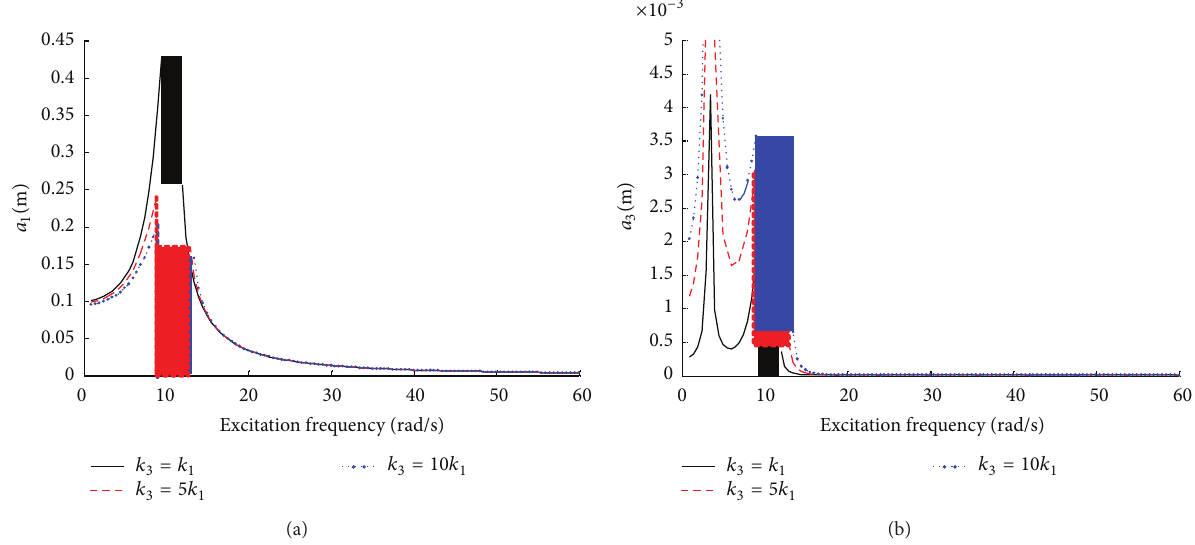
Figure 6: Influence of the nonlinear stiffness on the vibration properties of the oscillator; the shadow range is the unstable range: (a) the influence on 𝑎 1 and (b) the influence on 𝑎 3